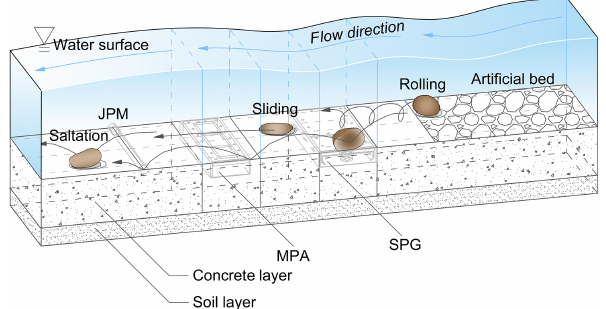
Figure 3. Sketch of bedload particles moving via different transport modes, including saltation, rolling, and sliding, over the Obernach flume